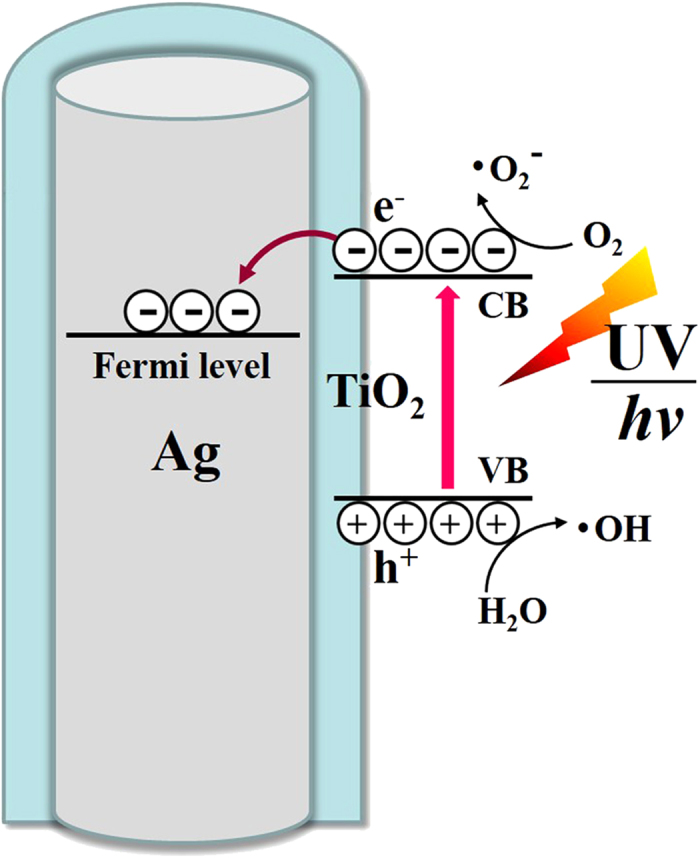
The schematic for the photocatalytic mechanism of Ag@TiO2 NRs.